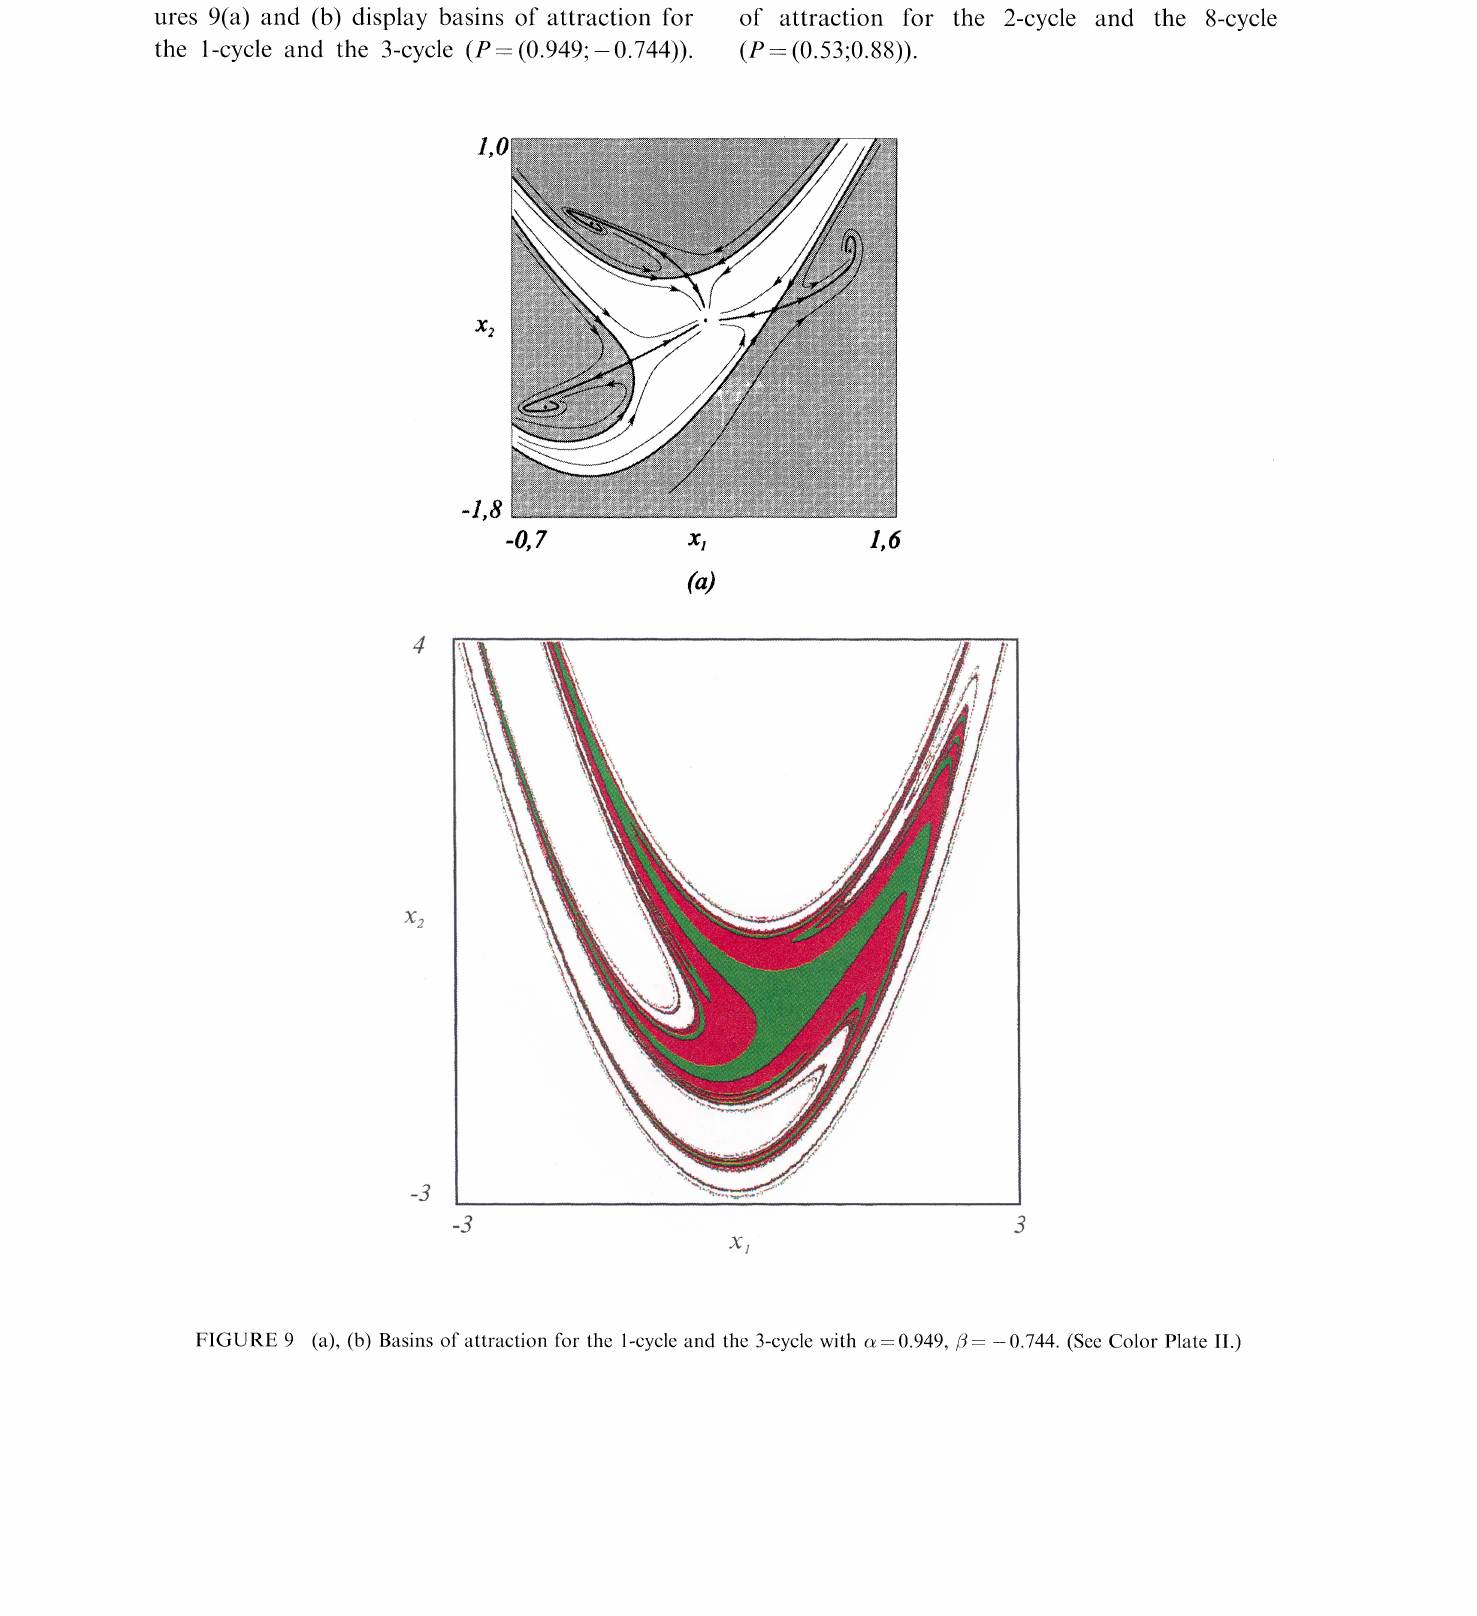
FIGURE 9 (a), (b) Basins of attraction for the 1-cycle and the 3-cycle with c 0.949, fl -0.744. (See Color Plate